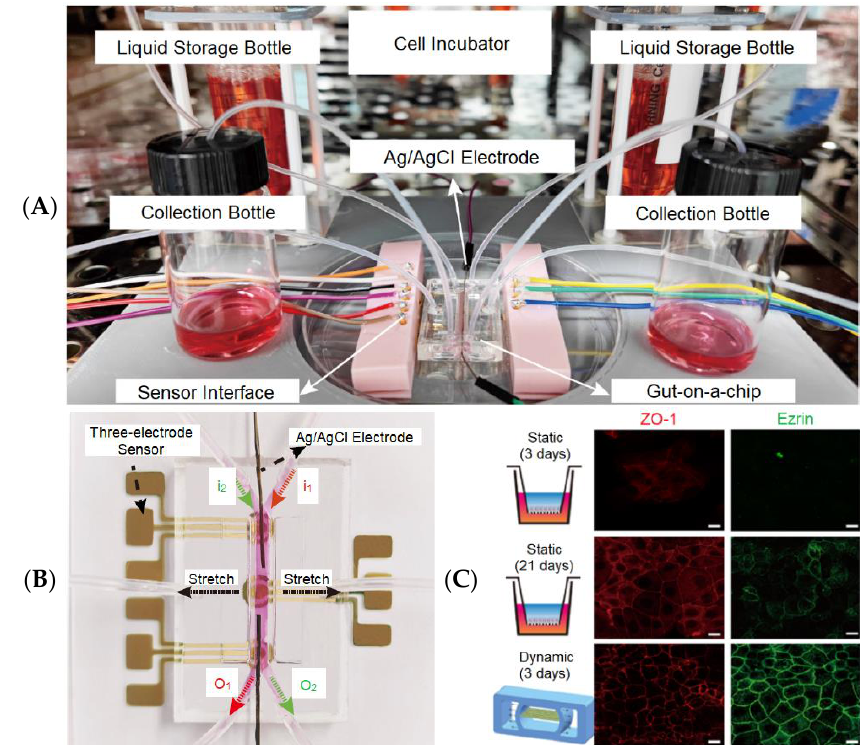
Figure 10. The gut-on-a-chip platform for exploring the transport mechanism of Hg(II) [68]. ( A ) The actual design of the gut-on-a-chip platform. ( B ) A photograph of the gut-on-a-chip connecting with multi-sensors. ( C ) A confocal fluorescence photograph of a tight junction protein (red-marked ZO-1) and brush border protein (green-marked ezrin) in static (3 days; 21 days) and dynamic cultures (3 days) (scale bar 20 μm). Reproduced with permission from Springer Nature Copyright (2023).